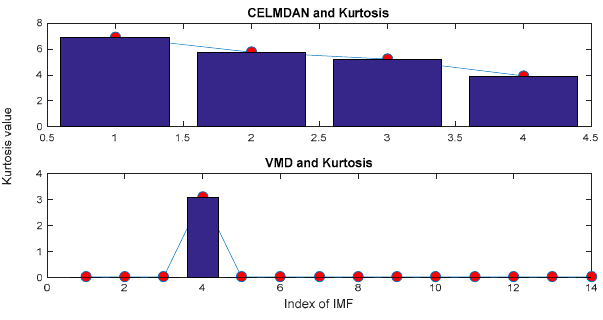
Figure 27. Selection of IIM with CELMDAN kurtosis and VMD kurtosis.